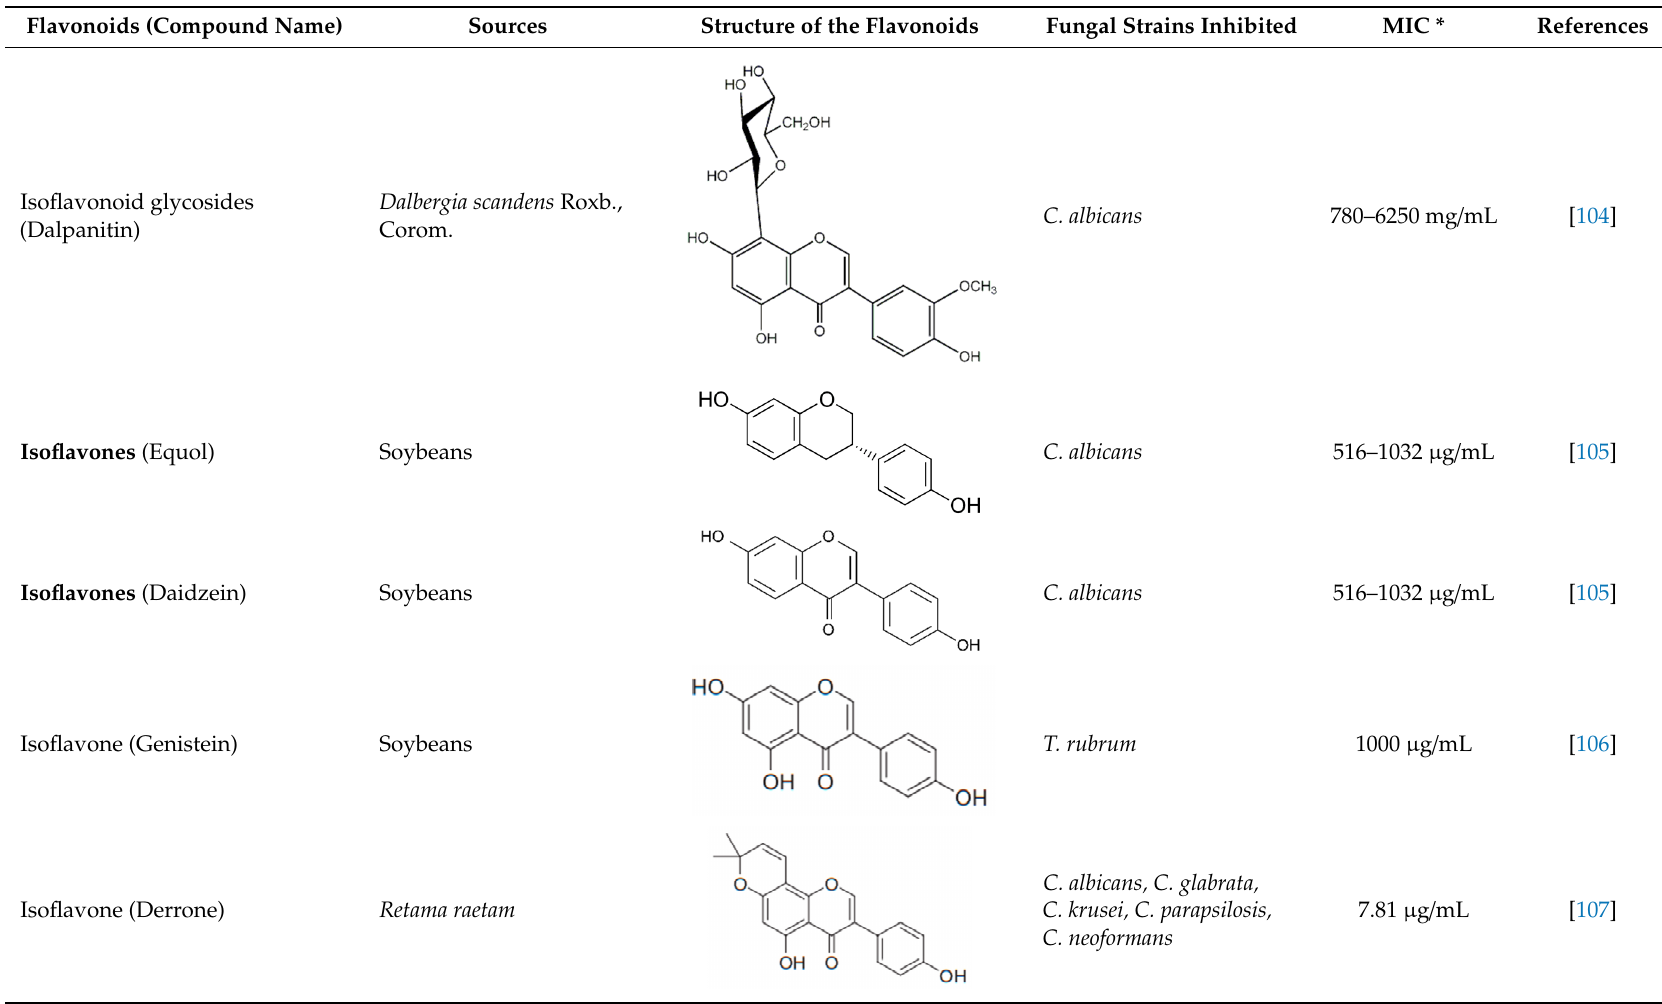
Table 1. Antifungal activities of flavonoids.